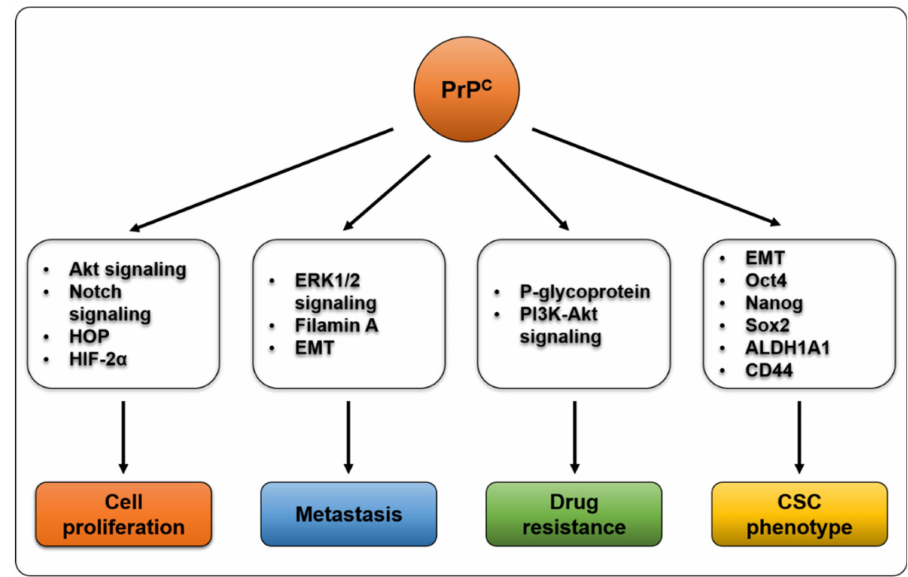
Figure 1. Proteins and signaling pathways that seem to be a ff ected by PrP C expression. Various proteins and signaling pathways reportedly interact with or are modulated by PrP C . Some of the proteins shown are known to be regulated indirectly through other proteins rather than direct interaction with PrP C . PrP C : prion protein, ECM: extracellular matrix, CSC: cancer stem